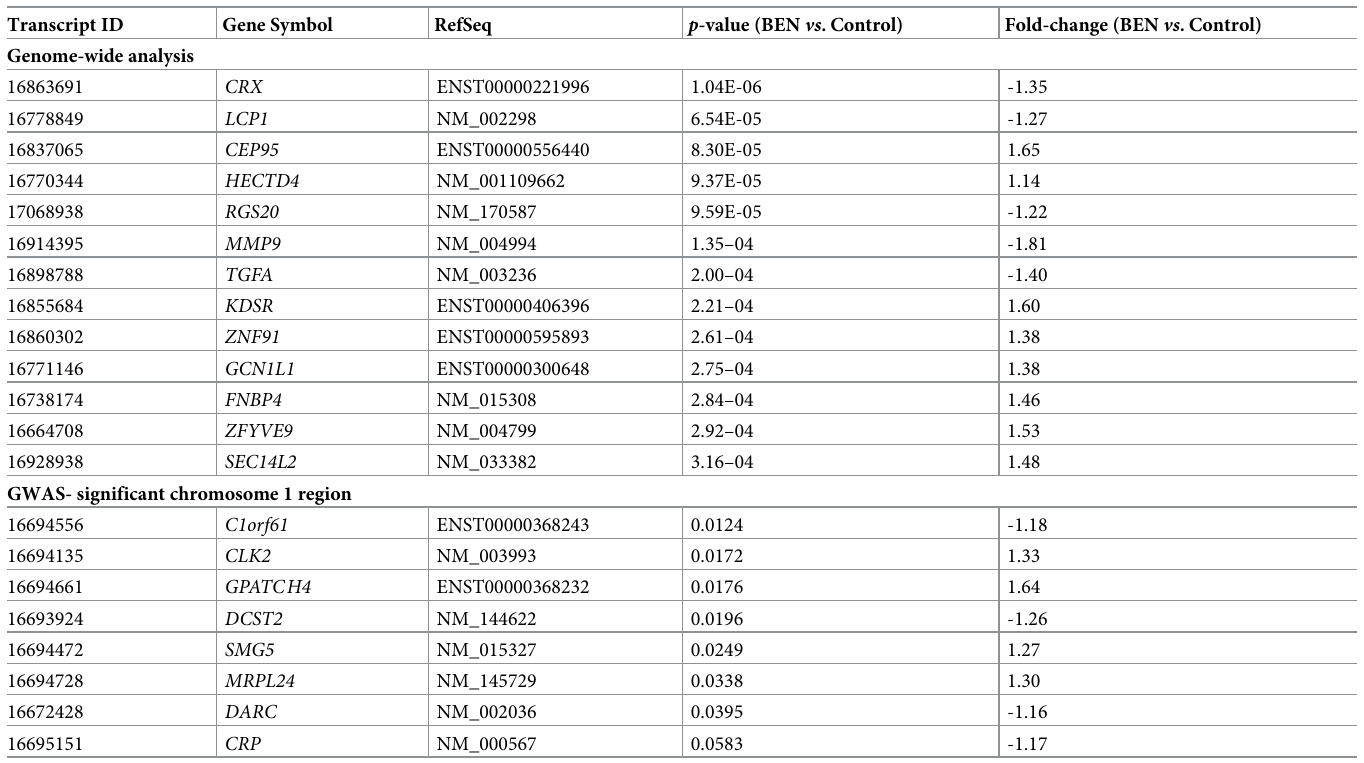
Table 3. Most differentially expressed genes in GWAS-significant chromosome 1 region.